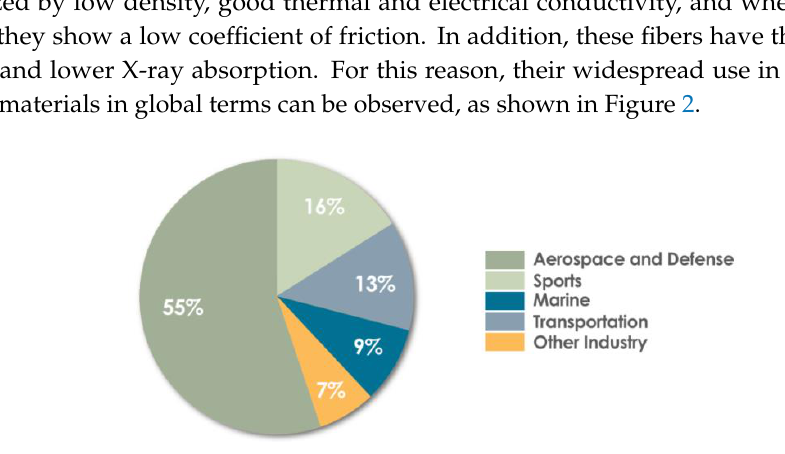
Figure 2. Areas of application for carbon fibers (based on: [22]).